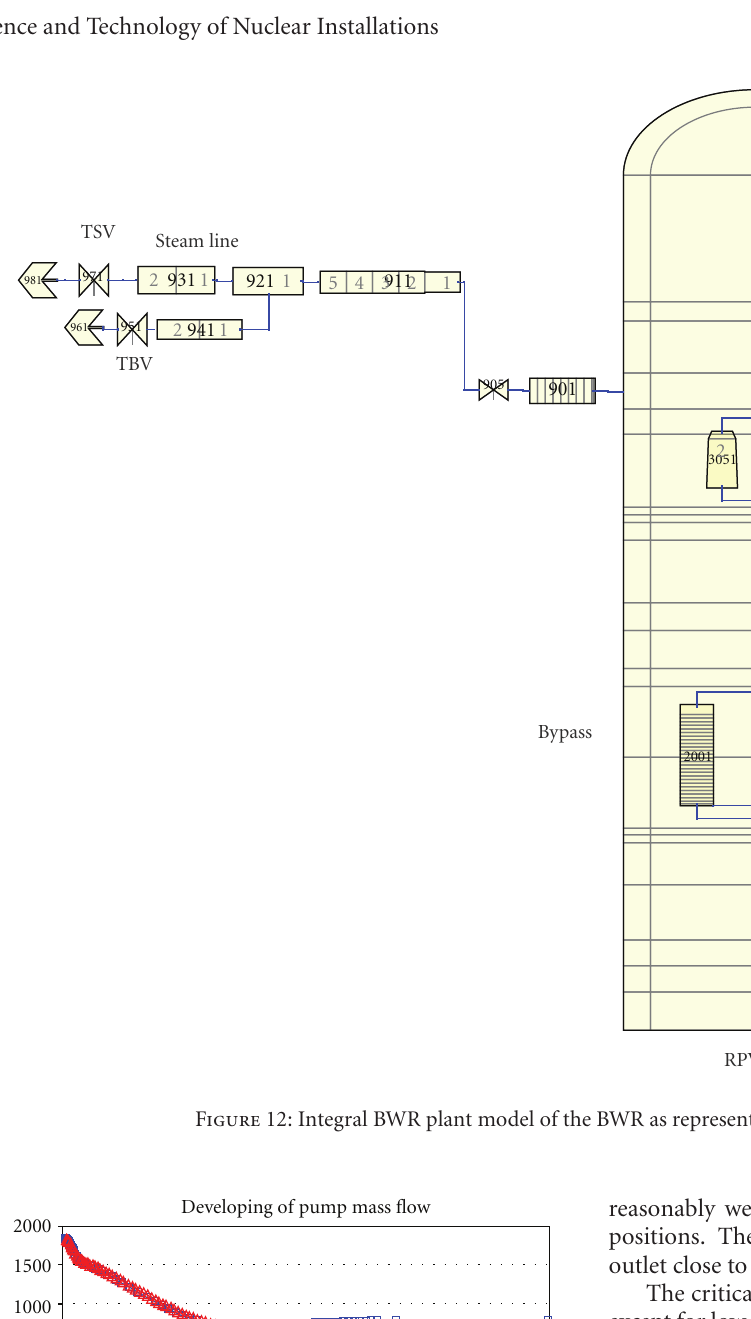
predicted void fractions for the di ff erent bundle arrange- ments with the data indicates that TRACE is able to